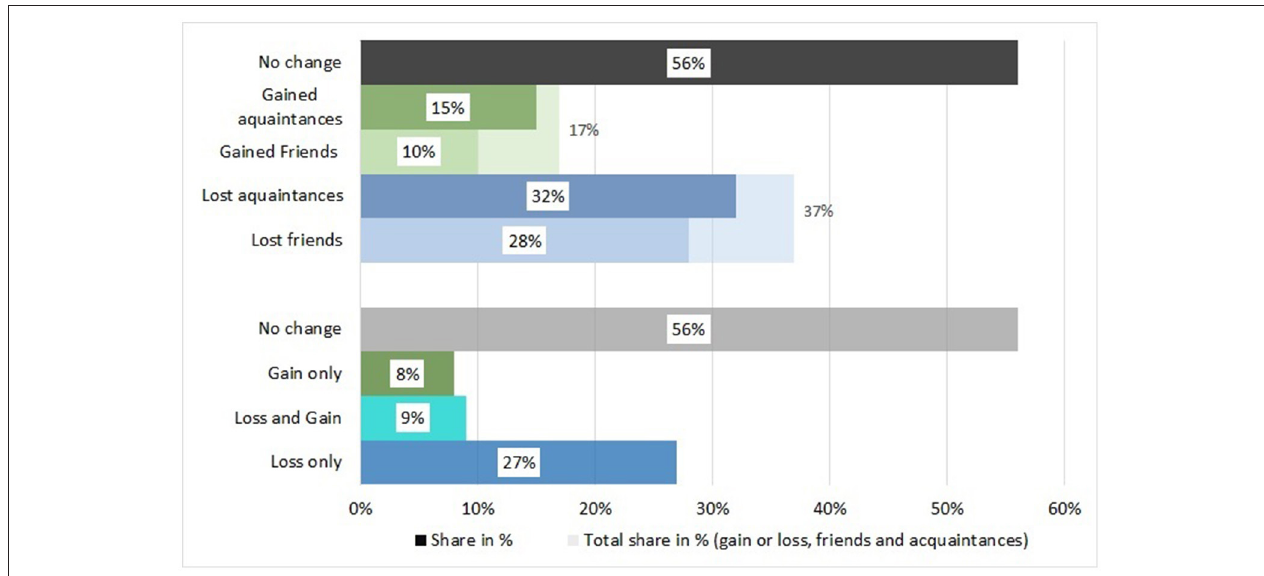
FIGURE 1 | Change in social ties. Source: Survey “Living in exceptional circumstances,” Wave 3 (spring 2021). n = 3,713 respondents, 18–98 years. Own calculations, applying population weights based on gender, age, education, migration background and region, calculated on the basis of German census data.